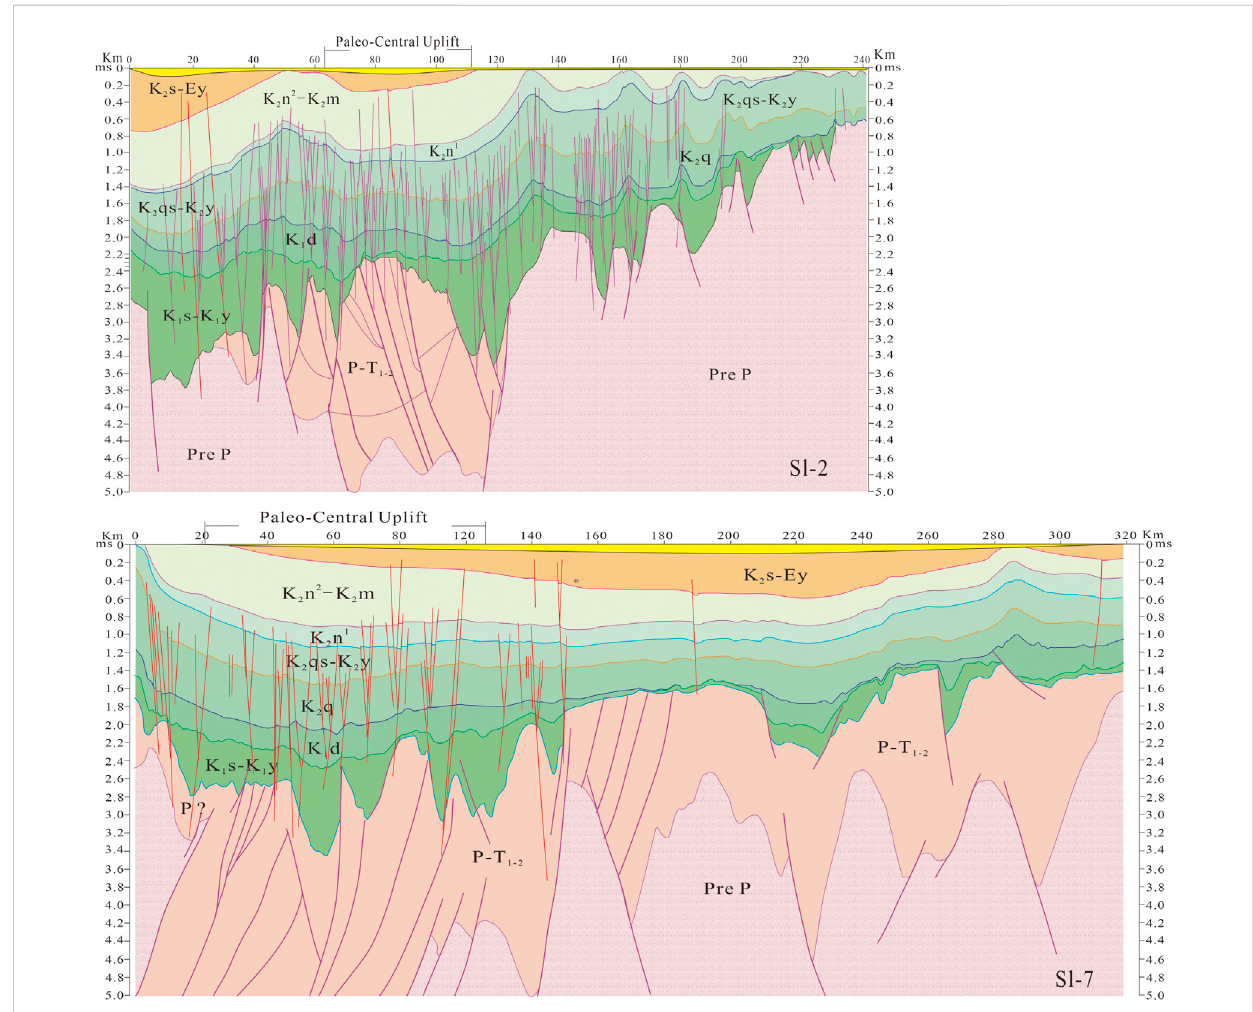
FIGURE 3 Structural pro fi le of SL-1 and SL-2 in Songliao Basin (locations of the section are shown in Figure 1).